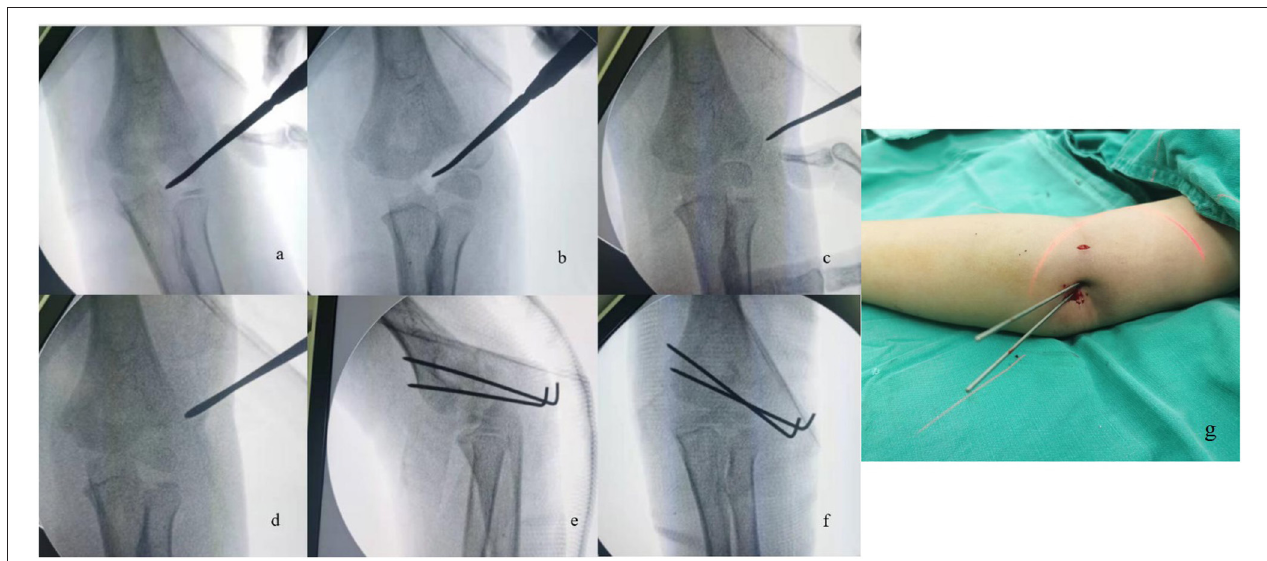
FIGURE 1 | (a) A Dura dissector was placed into the lateral cortex under c-arm fluoroscopy. (b) The rotated fragment was reduced by Dura dissector prying. (c) The elbow was fully extended with forearm supination, and direct compression was applied by a surgeon’s thumb on the distal fragment medially and anteriorly to minimize the fracture gap. (d) Assurance that the fracture gap was no more than 2mm. (e,f) Two percutaneous k-wires were inserted for fixation in AP and oblique internal rotational view. (g) The minimal lateral incision after the CRPP procedure in the treatment of